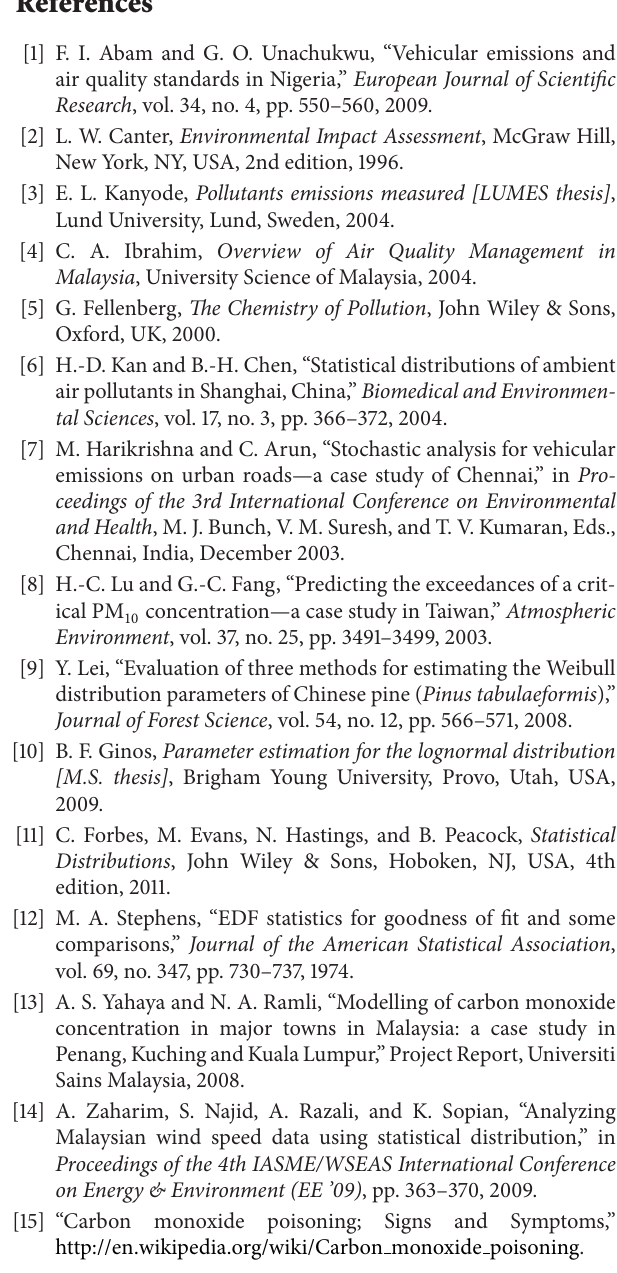
Table 9: Analysis of variance table. Source